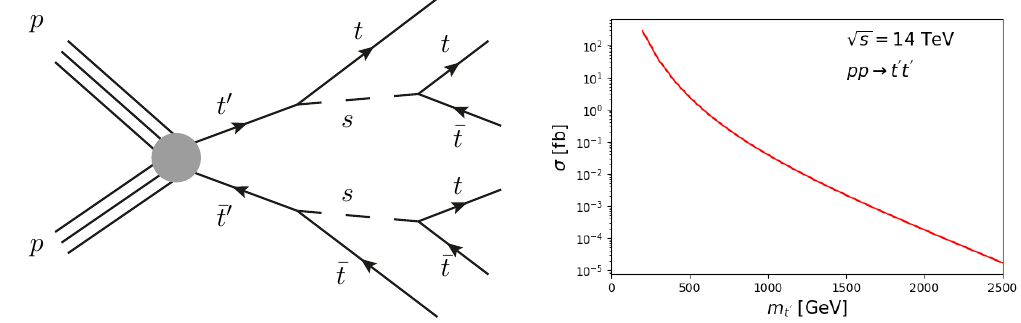
Figure 1 . Left: representative Feynman diagram for a 6 top (cid:12)nal state through top-partner pair production. Right: the cross section for top-partner pair production at the LHC with as function of top-partner